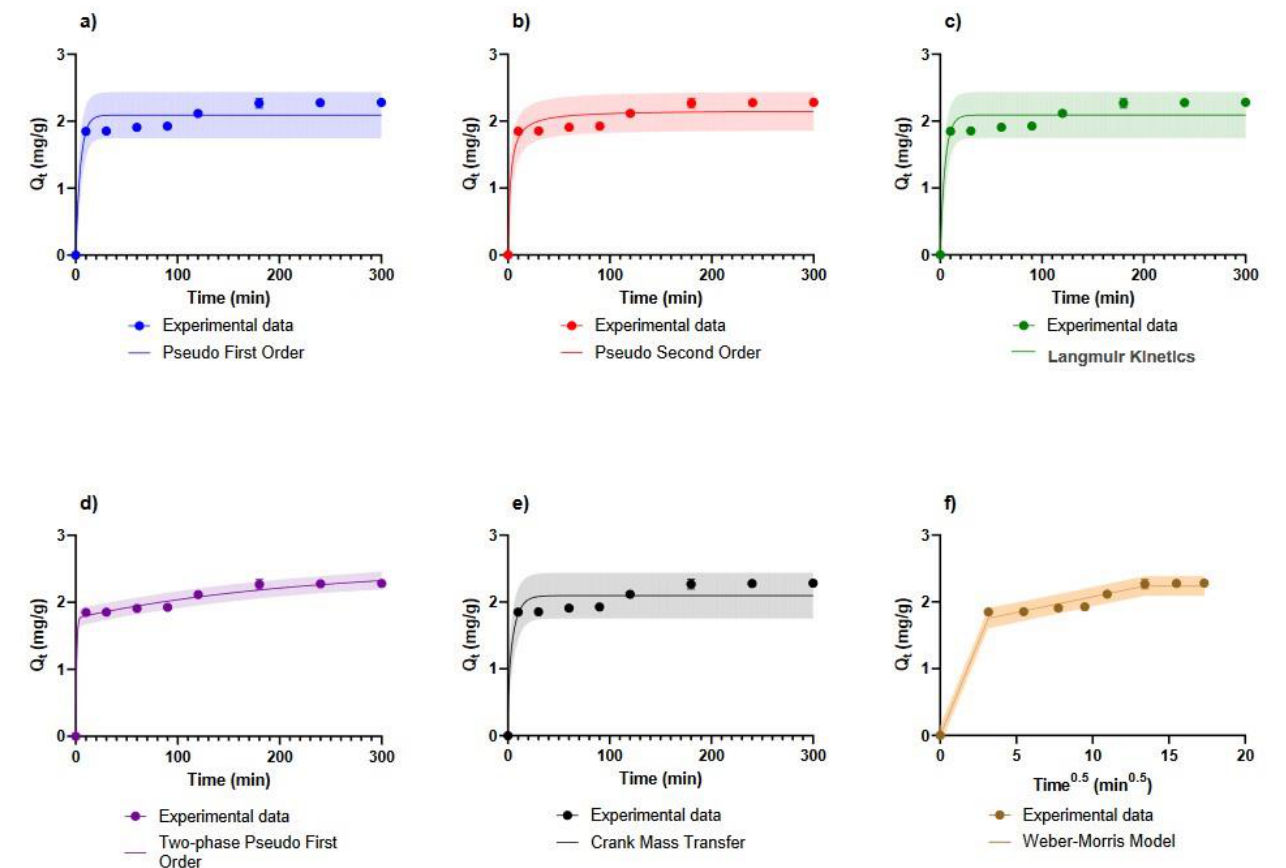
Figure 11. Different kinetic models fitted to the kinetic data for the adsorption of Cr(VI) to the adsorbent. The models were: ( a ) Pseudo First Order, ( b ) Pseudo Second Order, ( c ) Langmuir Kinetics, ( d ) Two-phase Pseudo First Order, ( e ) Crank Mass Transfer Model, ( f ) Weber-Morris Model. The shaded areas represent the 95% prediction intervals for the respective model fits. The optimised model parameters are reported in Table 5.